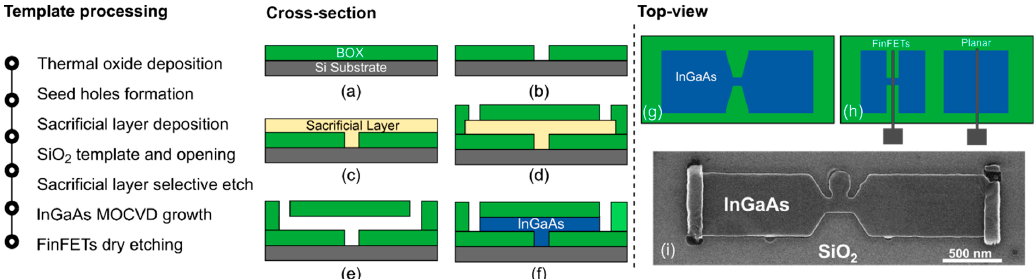
Figure 1 . Overview of the fabrication process. (left) process flow up to the InGaAs fin formation. Cross ‐ section schematic of ( a ) thermal oxide formation on silicon substrate, ( b ) patterning and opening of seed area in the oxide layer, ( c ) sacrificial layer deposition, ( d ) oxide template deposition and patterning of opening areas, ( e ) selective removal of sacrificial material, ( f ) III ‐ V MOCVD growth. Top ‐ view schematic of ( g ) as ‐ grown InGaAs structure after SiO 2 template strip and ( h ) planar and FinFETs structures after dry etching. ( i ) SEM top ‐ view image of grown InGaAs structure from a seed positioned off ‐ center.